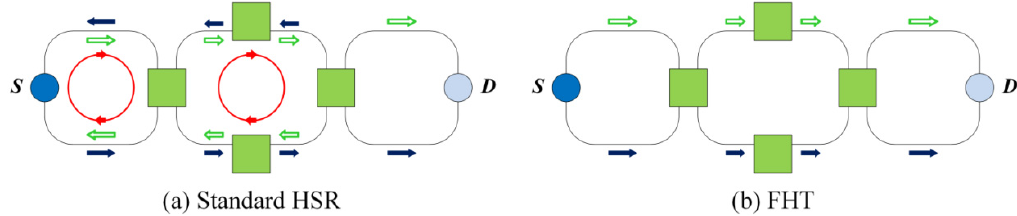
Figure 5. Forwarding a unicast frame from node S to node D.